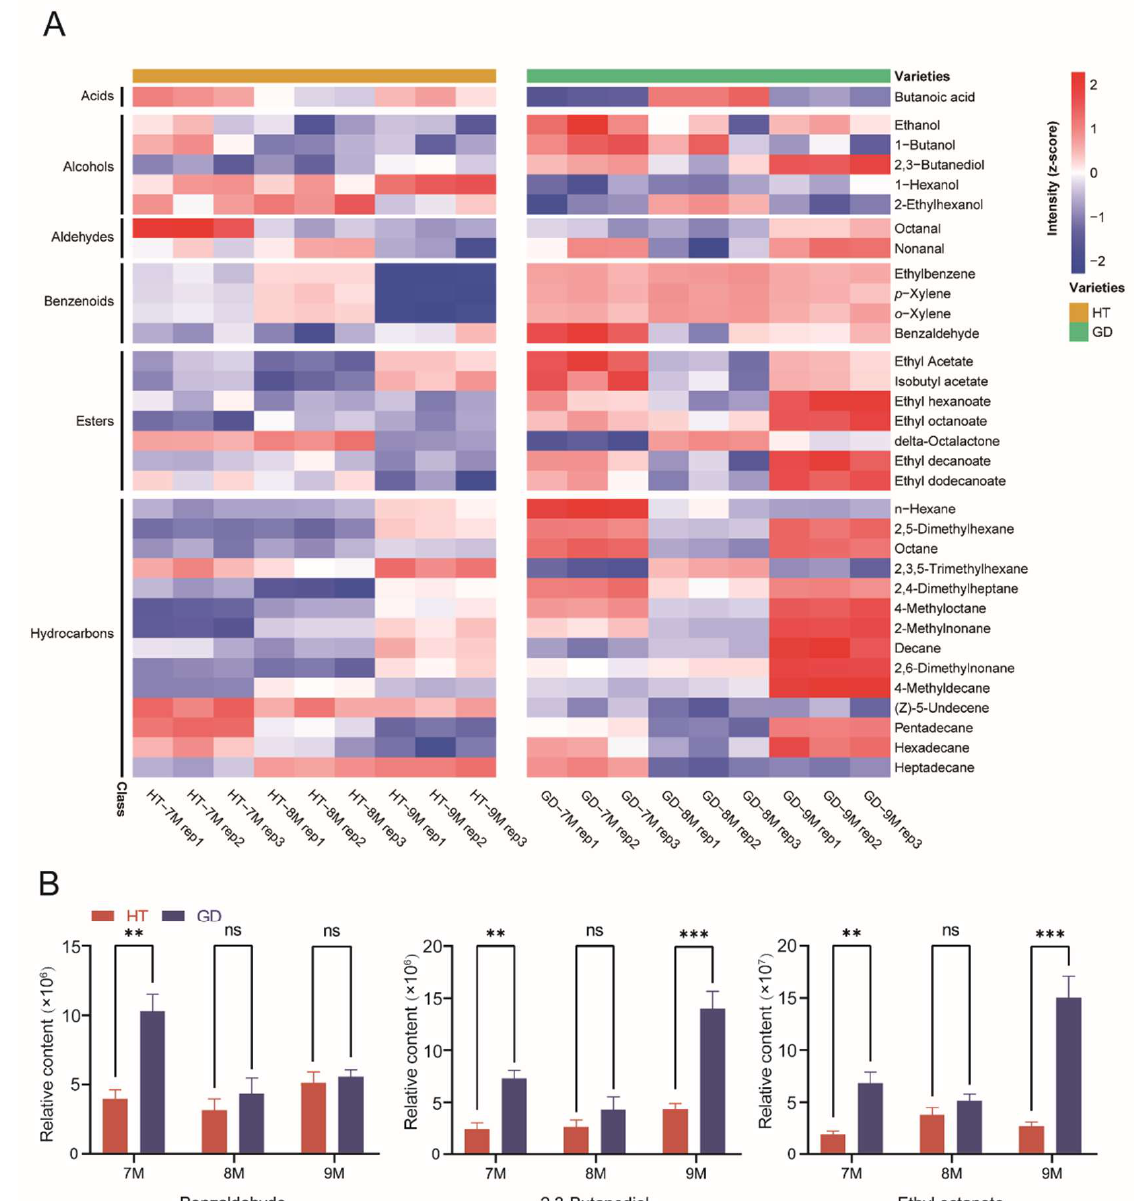
Figure 2. Analysis of coconut flesh volatile accumulation patterns between two coconut varieties over three growth stages. ( A ) The levels of volatile of coconut flesh in two coconut varieties over three growth stages are shown in the heatmaps. Volatiles were arranged by metabolite classes. ( B ) Comparative analysis of volatiles in the flesh of two coconut varieties at three different growth stages. Student’s t test was performed (ns: not significant, ** p < 0.01, *** p < 0.001).